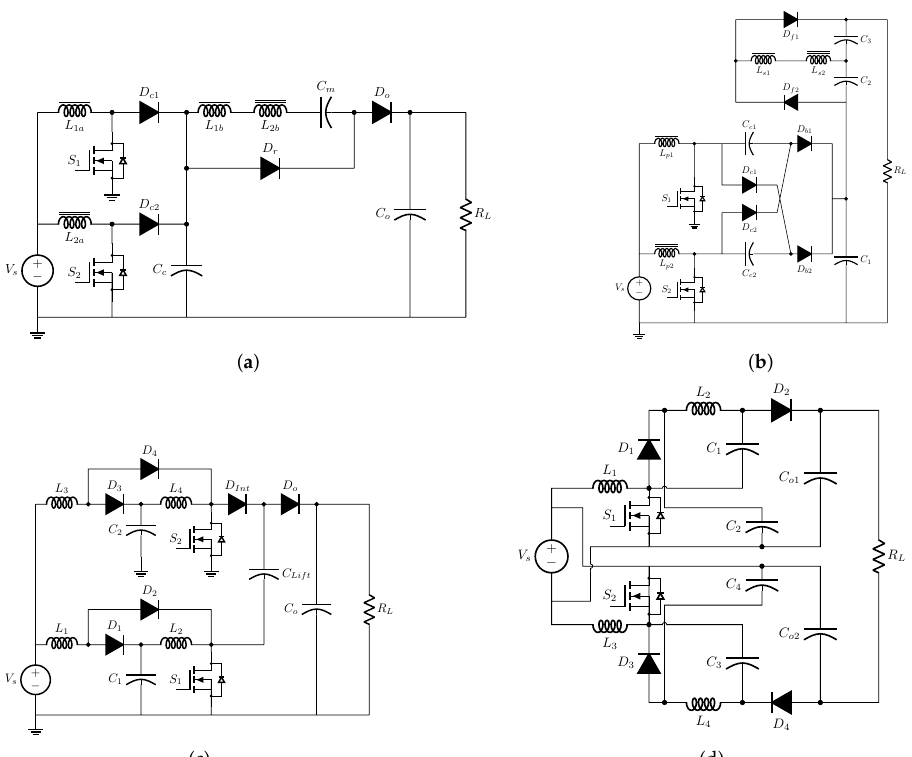
Figure 7. Interleaved Converters. ( a ) Interleaved with VMC and Coupled Inductor, ( b ) Interleaved with VMC based on SC and Coupled Inductor, ( c ) Interleaved QBC and ( d ) Tow Interleaved Modified Step-Up KY